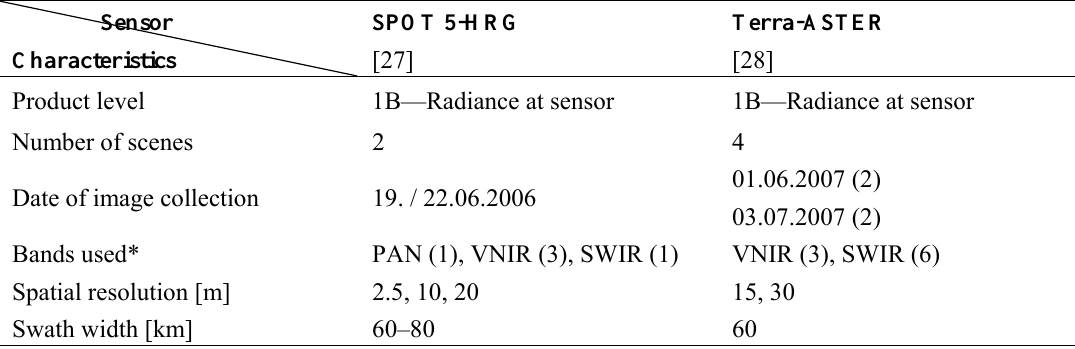
Table 1. Characteristics of the ASTER and SPOT images used in this